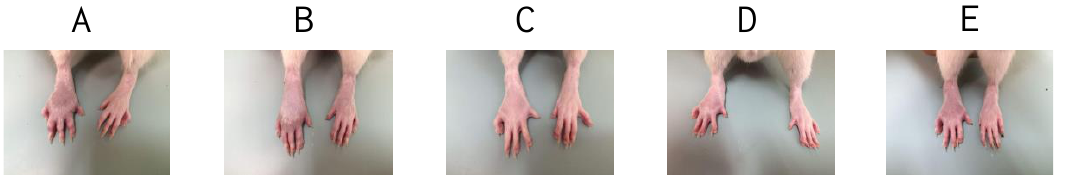
Figure 3. Edema status after oral treatment (on day 25) with curcumin at different doses. (A) Vehicle, (B) Curcumin 60 mg/kg, (C) Curcumin 120 mg/kg, (D) Curcumin 150 mg/kg, and Phenylbutazone (80 mg/kg) (E).